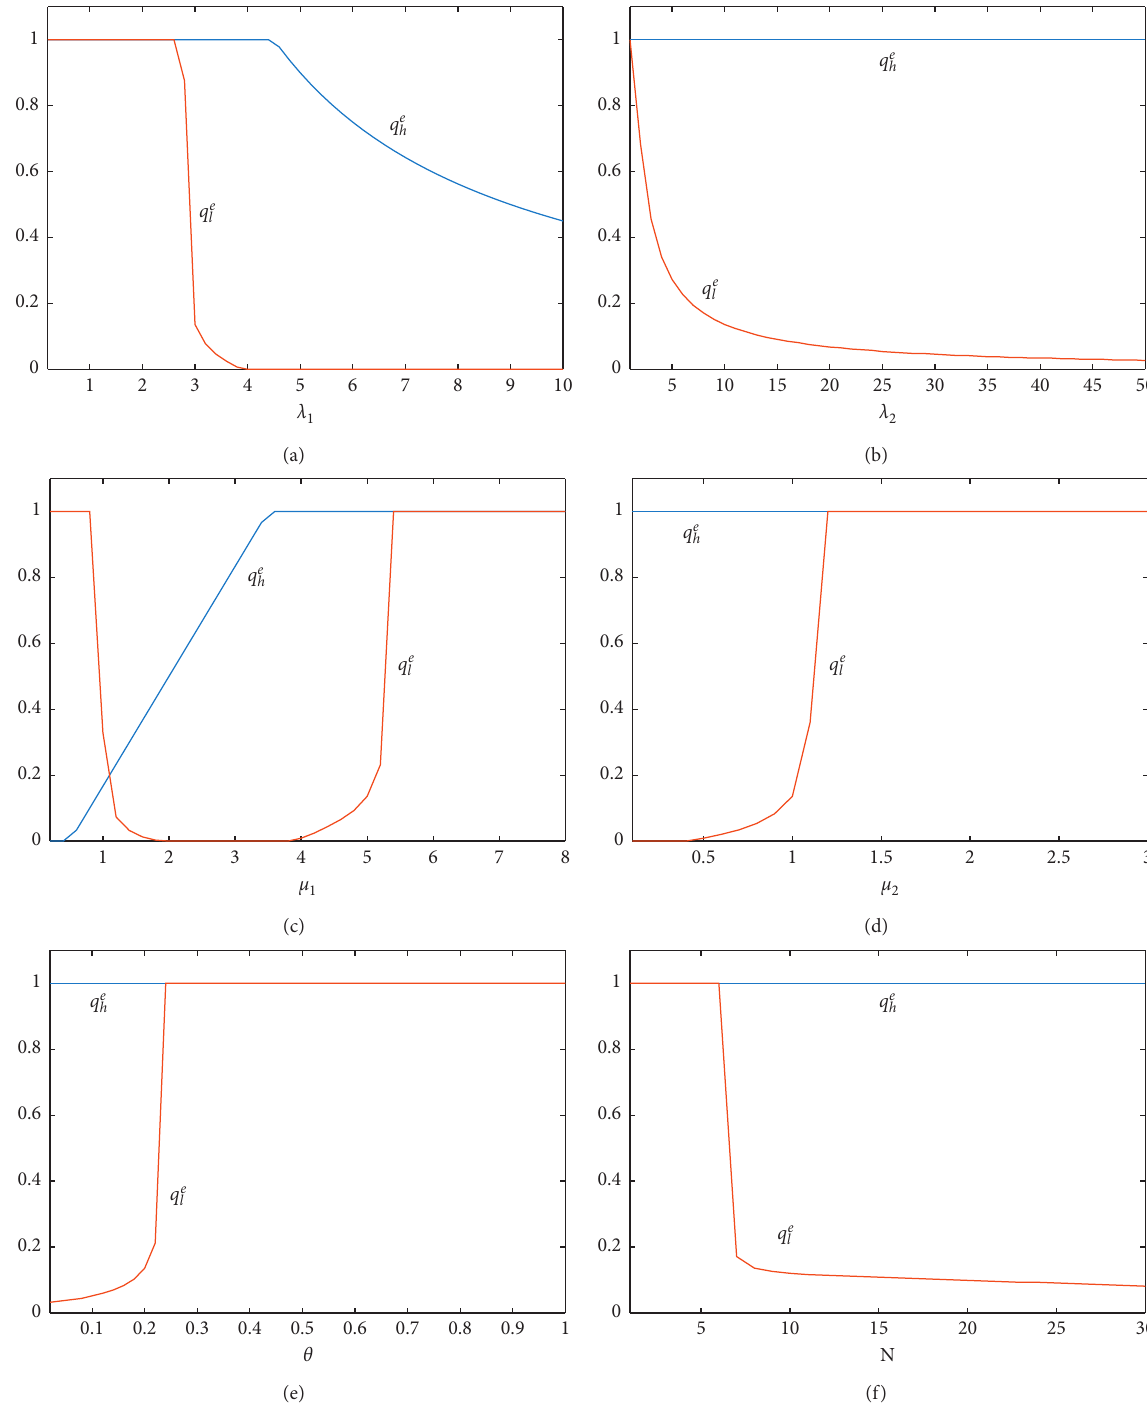
Figure 3: q e vs. θ . (f) q e